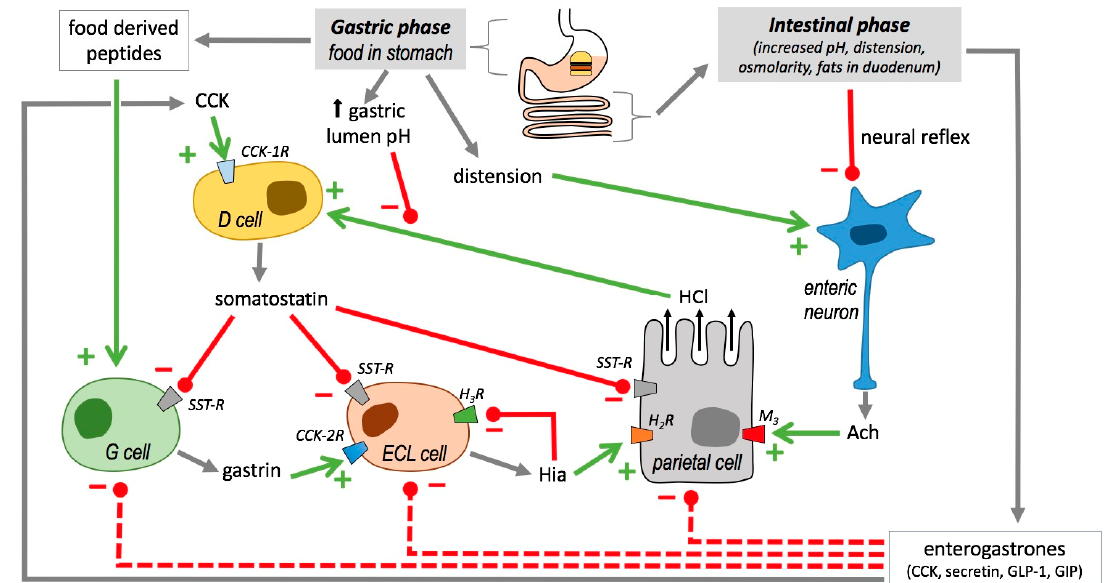
Figure 3. Balance between stimuli and inhibitors of gastric secretion. CCK, cholecystokinin; CCK n R, different types of cholecystokinin receptors (1 or 2); D cell, somatostatin-releasing cell; ECL cell, enterochromaffin-like cell; G cell, gastrin-producing cell. GLP-1, glucagon-like peptide; GIP, gastric inhibitory polypeptide; H n R, different types of histamine receptors; M 3 , muscarinic acetylcholine receptor type 3; SST-R, somatostatin receptors. Products are represented by grey arrows, activations by green plus symbols and arrows, and inhibitions by minus symbols and red bars.